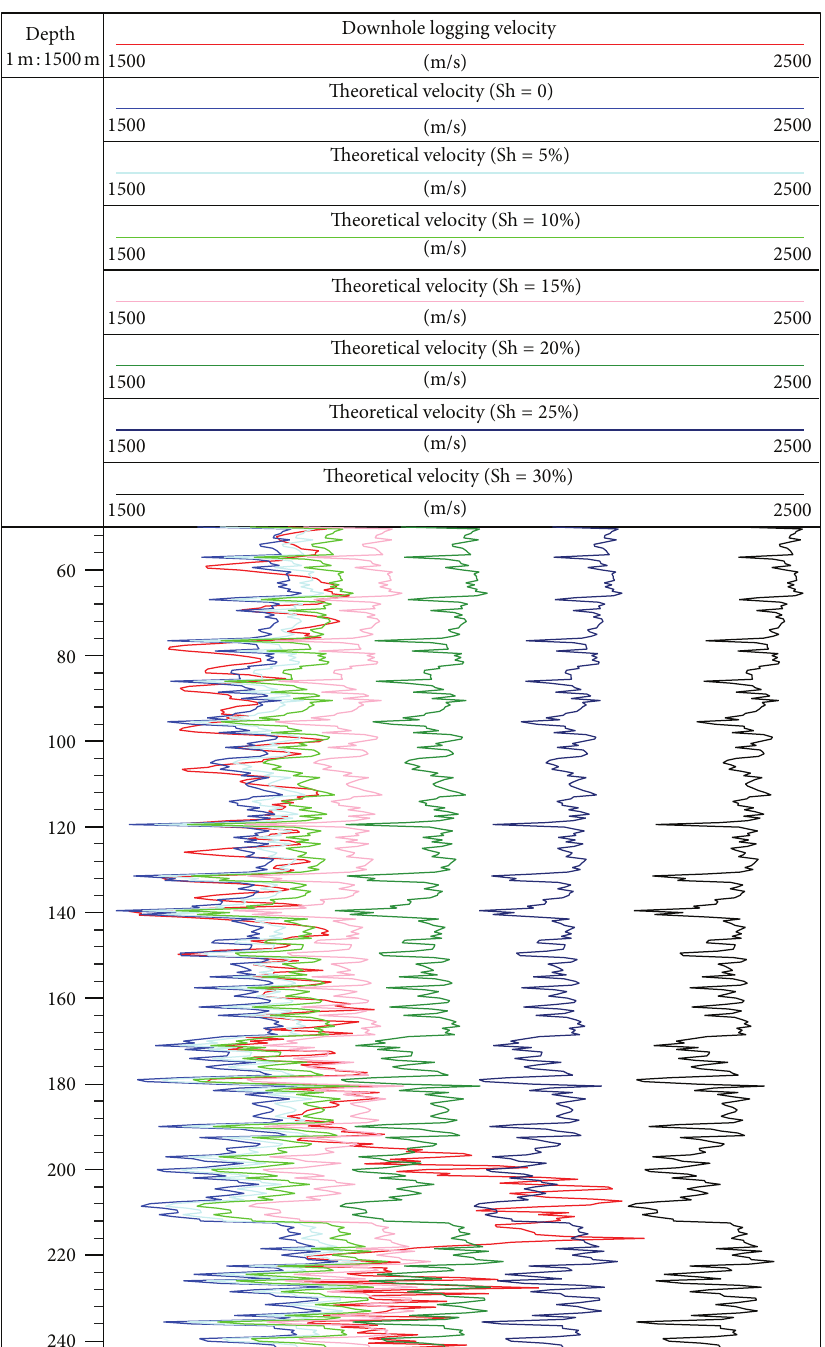
SH2, the porosity presents a decreasing trend except for the abnormality caused by borehole conditions in some intervals, and P wave velocity of forward stimulation (S